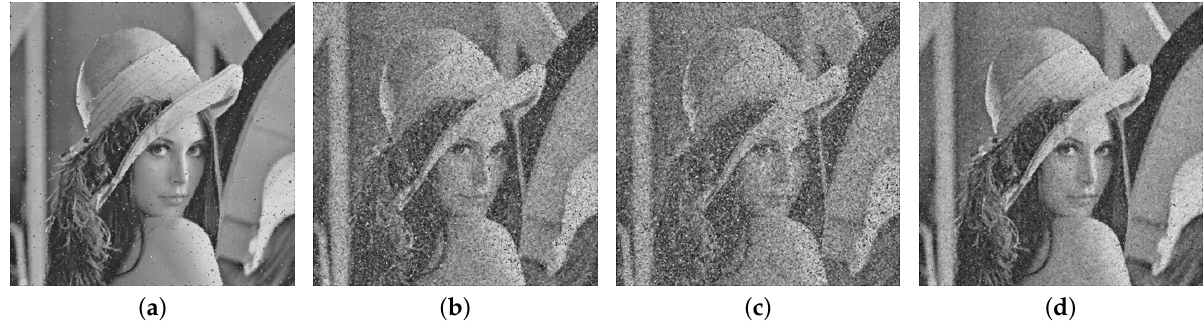
Figure 14. Reconstructed Lena after subjecting its corresponding cipher image to ( a ) 10% salt and pepper noise, ( b ) 2% speckle noise, ( c ) Gaussian noise with mean 0 and variance 0.02, and ( d ) Poisson noise. Table 9. PSNR values between the plain image Lena and the reconstructed image after noise attacks on corresponding cipher images. Noise PSNR Salt and pepper (density 0.1) 26.4083 Speckle (density 0.02)